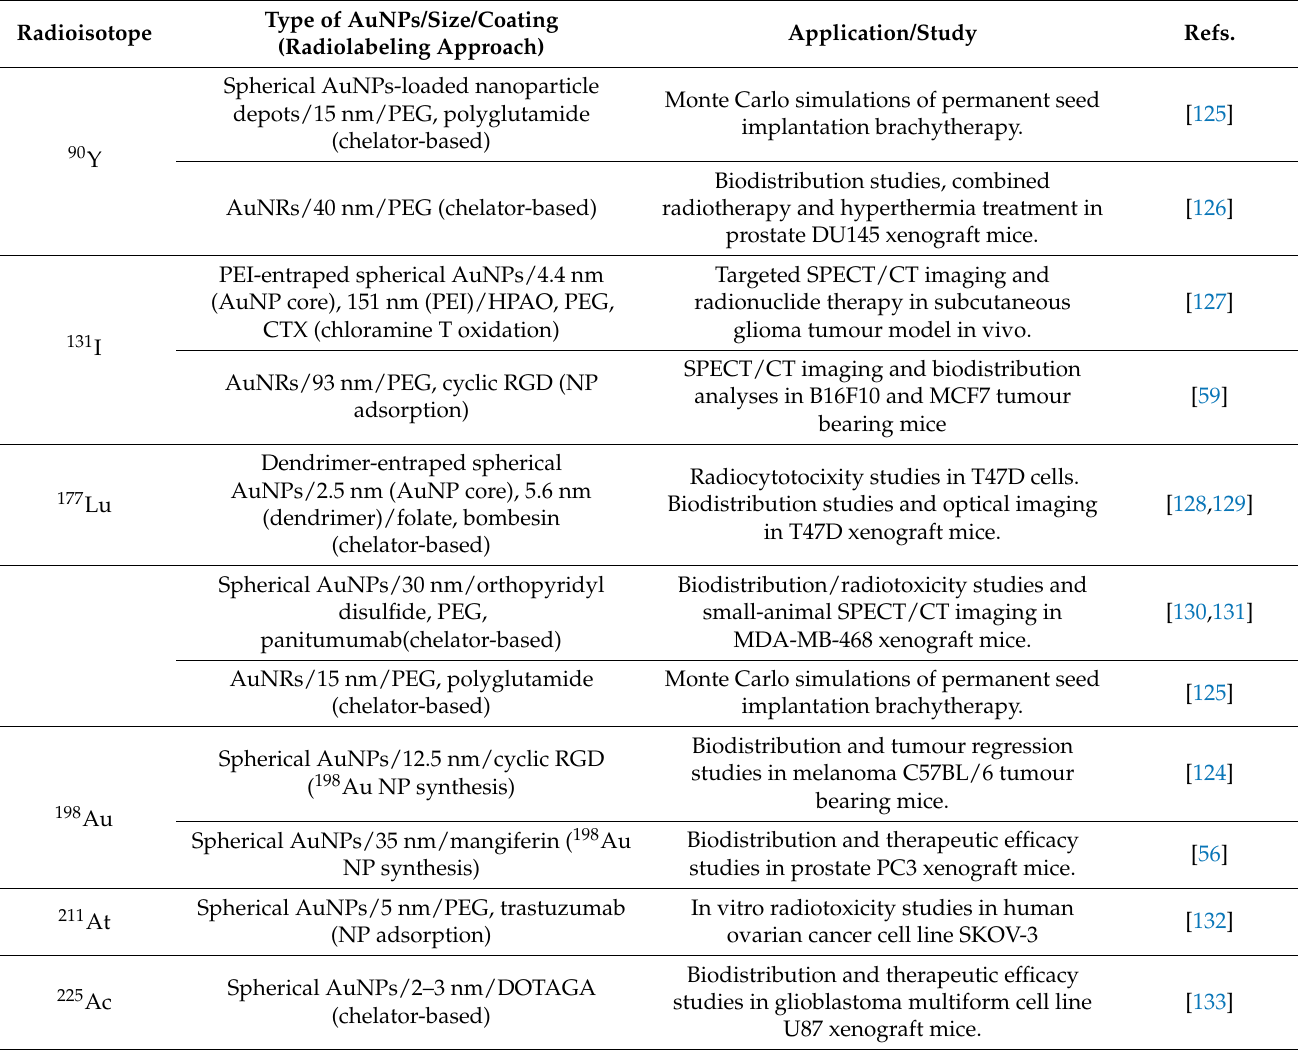
Table 4. Examples of AuNPs labeled with therapeutic radionuclides and respective preclinical studies. Radioisotope Application/Study